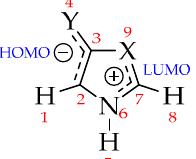
Figure 3. Expected charge separation for mesoionic compounds [15]. Table 5. NBO charges on exo and endocyclic atom groups on the aug-cc-pVDZ basis set. Values in parentheses correspond to the partial charges of exo Y and endo X atoms.